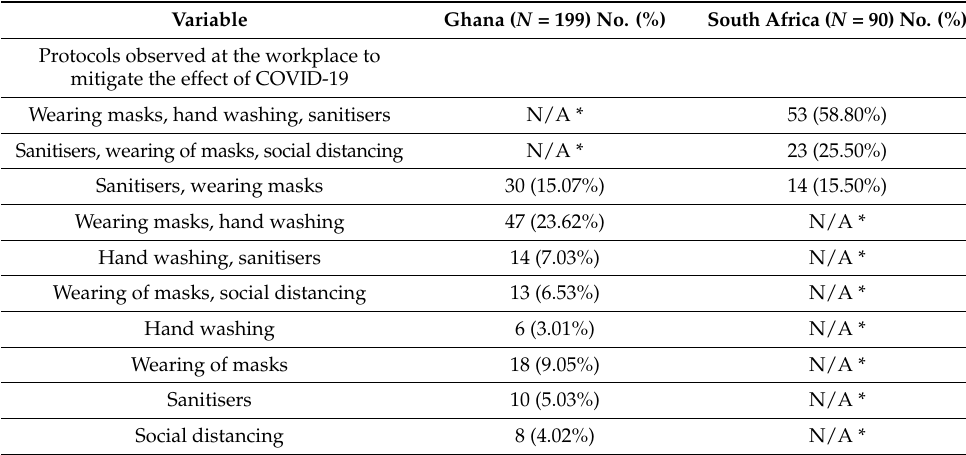
Table 6. Strategies put in place to fight COVID-19 at the workplace. Variable Ghana ( N = 199) No. (%) South Africa ( N = 90) No.